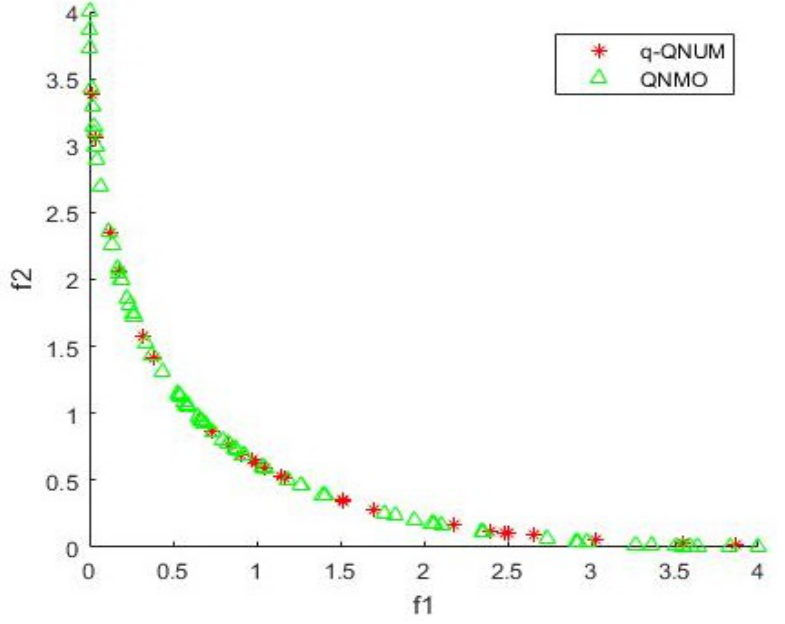
Figure 1. Approximate Pareto Front of Example